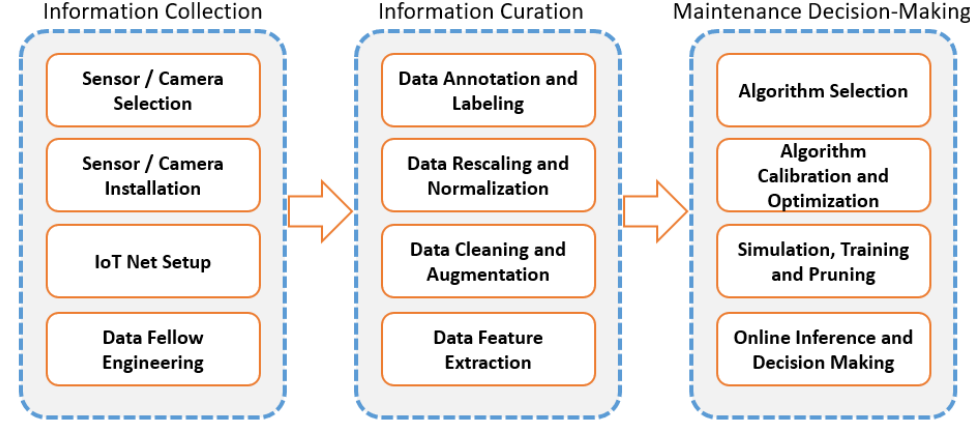
Figure 1. Main steps of an automated Fault Detection and Diagnosis